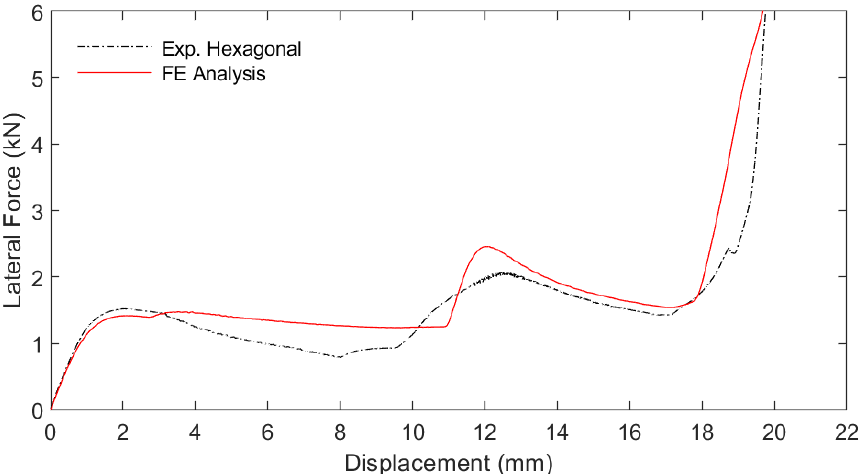
Figure 23. Load vs. displacement curves for hexagonal cell under lateral load: comparison between experimental and FEA.